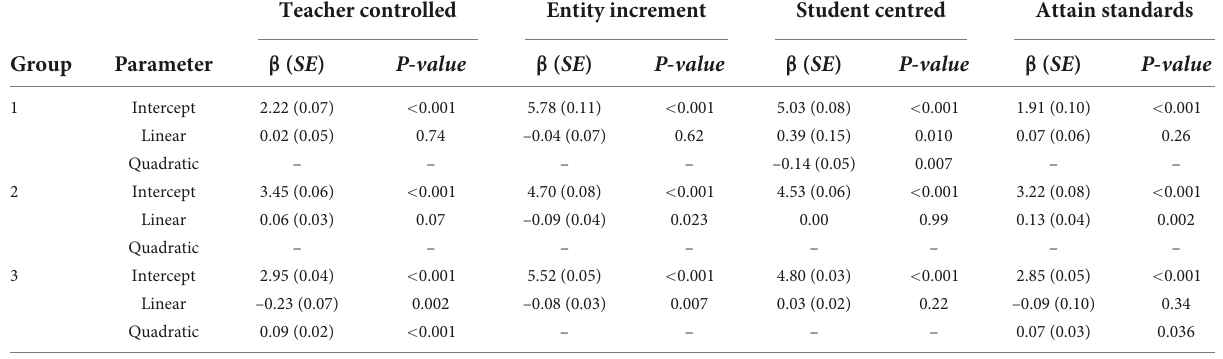
TABLE 2 Estimates of beliefs trajectory parameters.